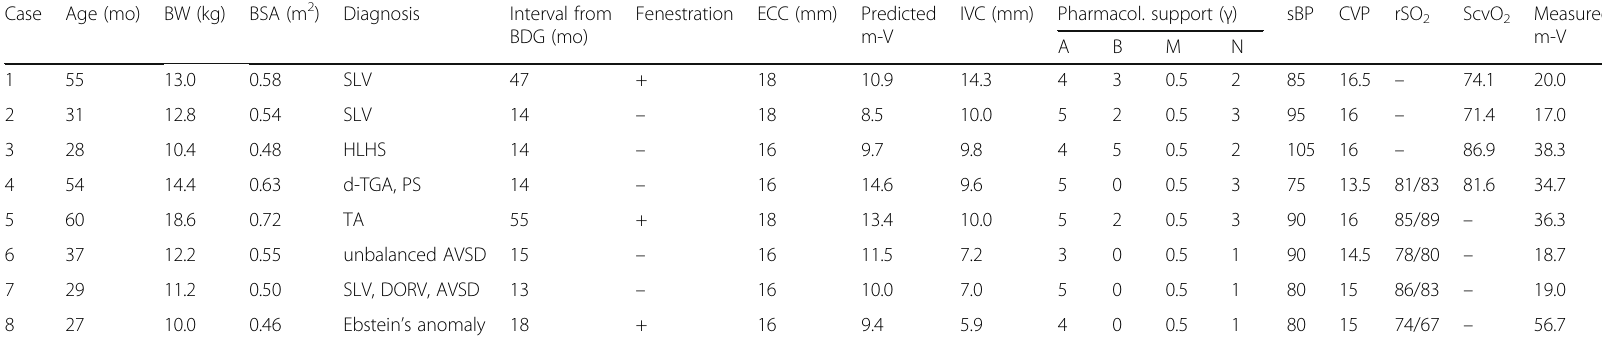
Table 1 Demographic backgrounds of the patients studied Case Age (mo) BW (kg) BSA (m 2 )